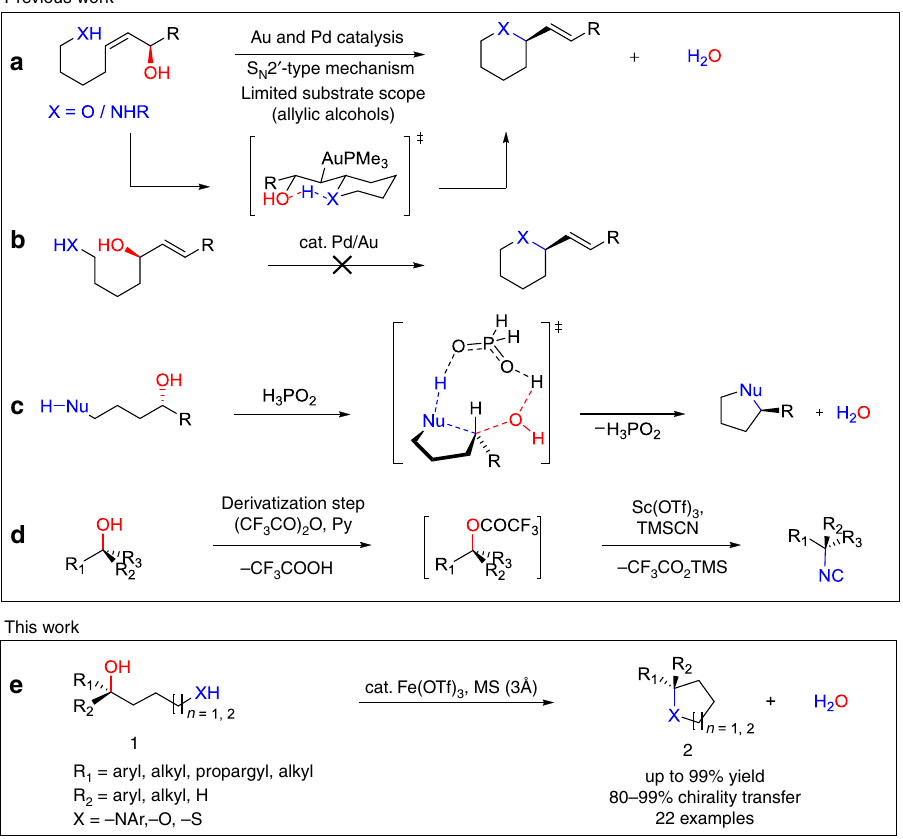
Fig. 1 Substitution of the OH groups of enantioenriched alcohols with chirality transfer. a , b , Gold-catalyzed and palladium-catalyzed S N 2 ′ -type allylic amination and etheri fi cation reactions. c Phosphinic acid-catalyzed S N 2-type intramolecular substitution of the OH groups of secondary alcohols. d Stereoinversion of tertiary alcohols by tertiary-alkyl isonitriles. e Iron-catalyzed intramolecular substitution with chirality transfer of the OH groups of enantioenriched secondary and tertiary